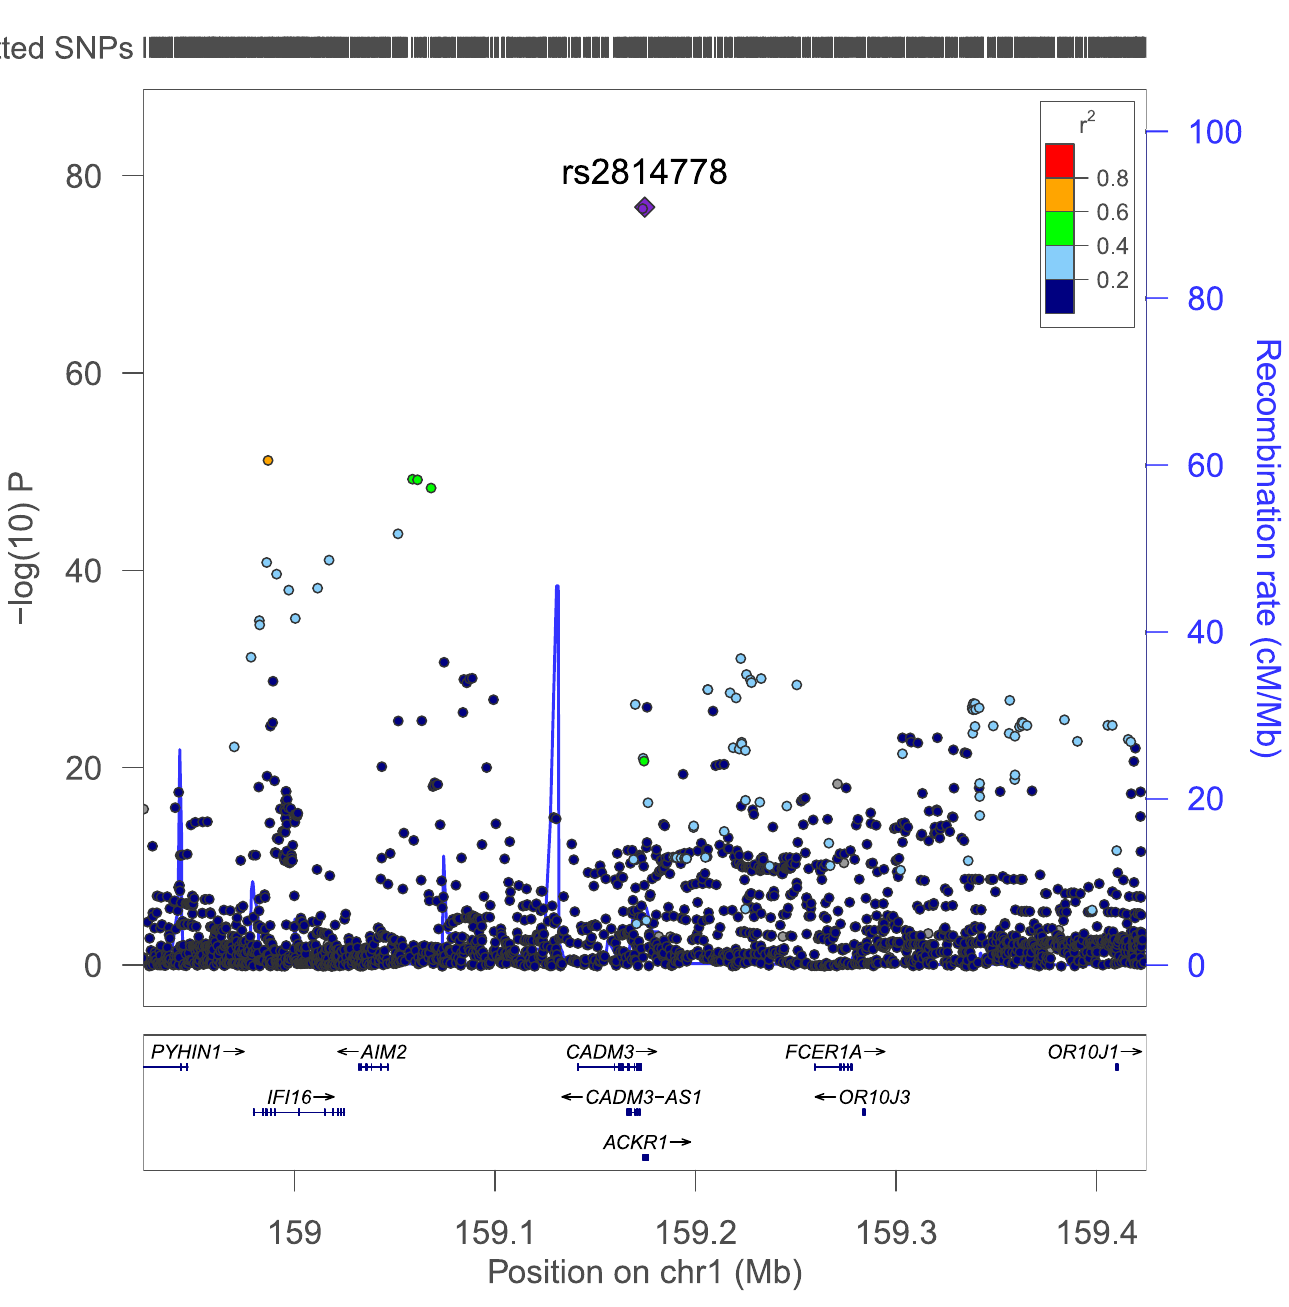
Fig 2. Regional association plot for chromosome 1 genome wide significant locus centered on DARC